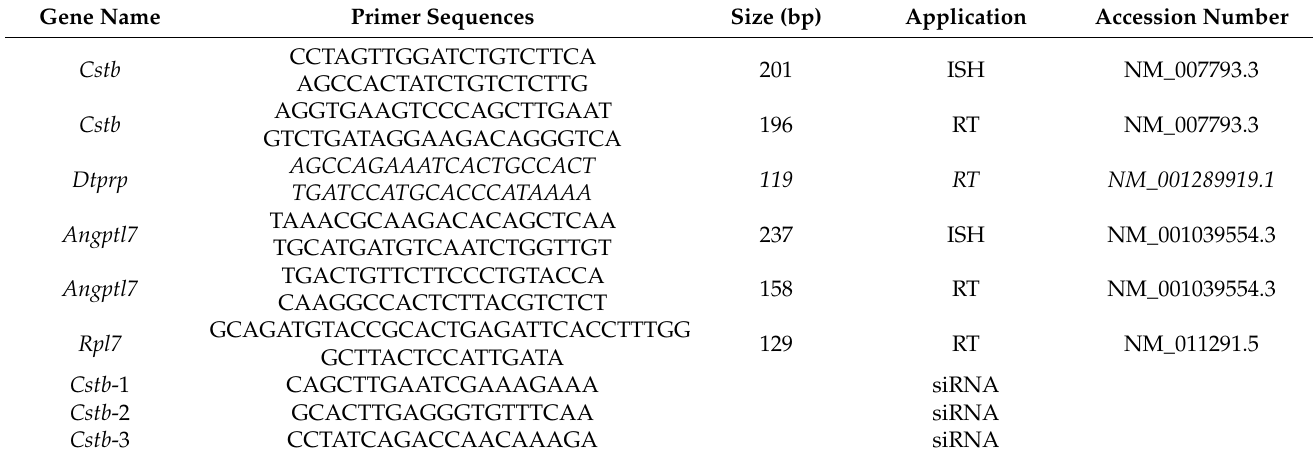
Table 1. Primers and siRNA sequences used in this